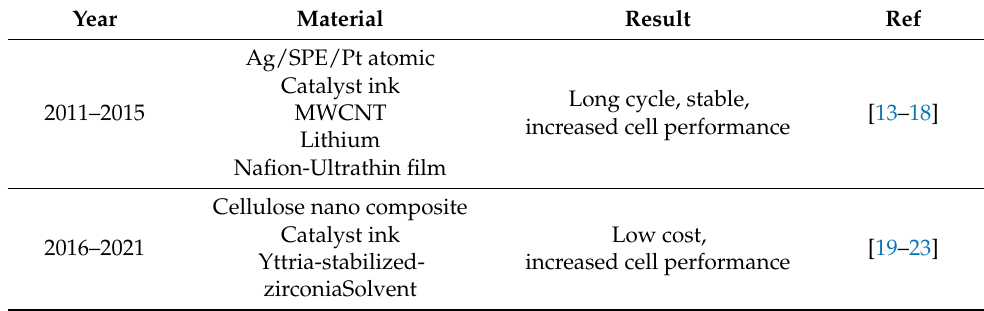
Table 1. Related works on inkjet printing in the last